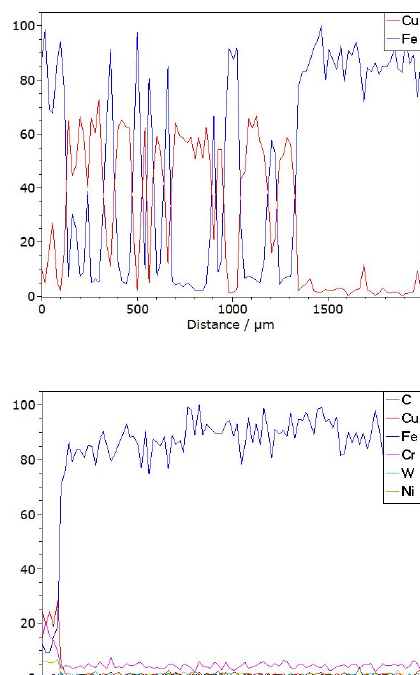
Figure 18. SEM images of the wear track and linear analysis of changes in chemical composition of ( a ) copper and ( b ) copper surface layer with Cr50WC50.